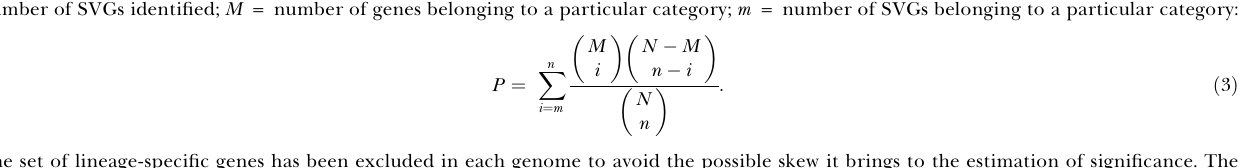
DOI: 10.1371/journal.pbio.0020081.g005